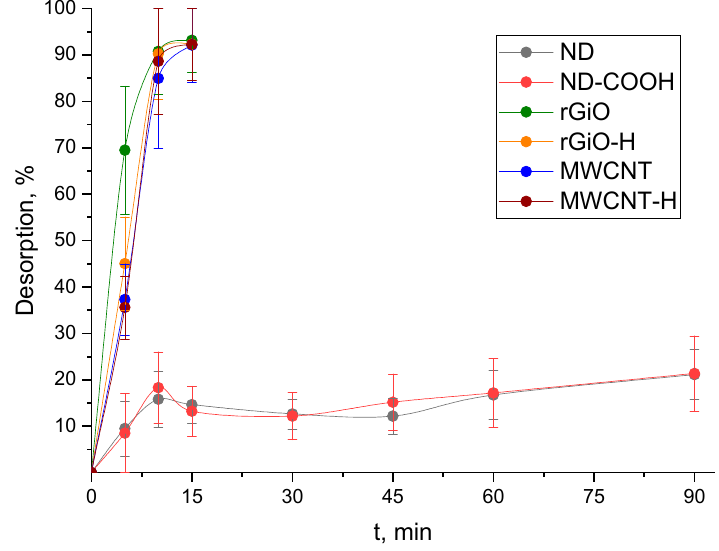
Figure 4. Desorption of 68 Ga from studied CNMs (100 μ g/mL) by the solution of 40 g/L bovine serum albumin (BSA) in phosphate-buffered saline (PBS) at 25 °C.